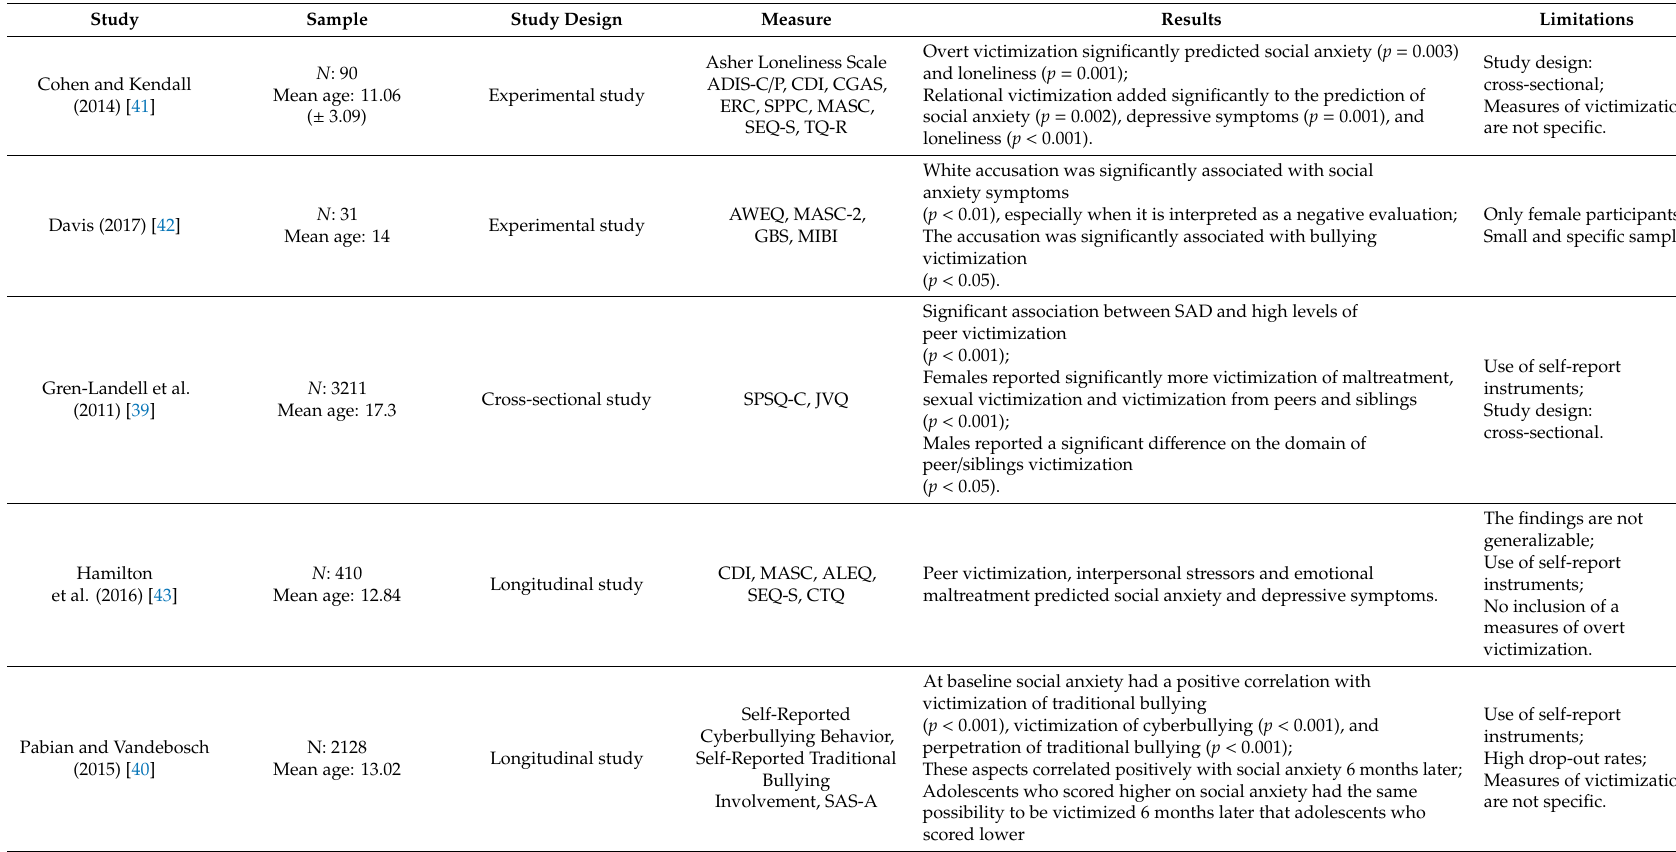
Table 1. Results of included